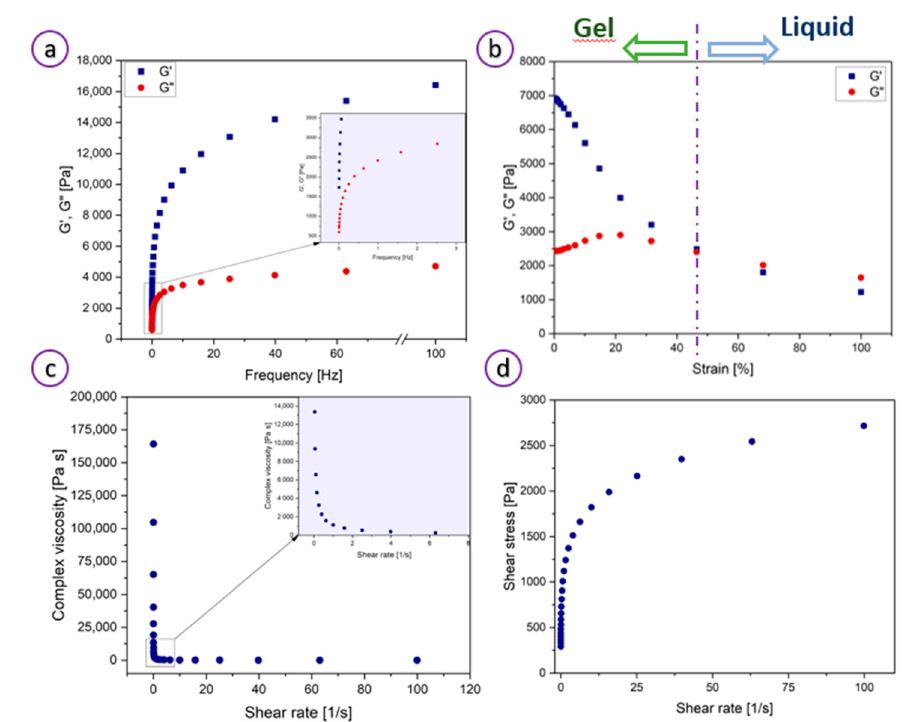
Figure 2. Rheological properties of the hydrogel ink: ( a ) Frequency and ( b ) strain (at a frequency of 1 Hz) dependence of storage and loss moduli. Inset in ( a ) shows the magnified plot for the frequency of 0–10 Hz; ( c ) Complex viscosity of the hydrogel precursor. Inset shows the magnified plot for the shear rate of 0–5 1/s; ( d ) shear stress vs. shear rate plot.